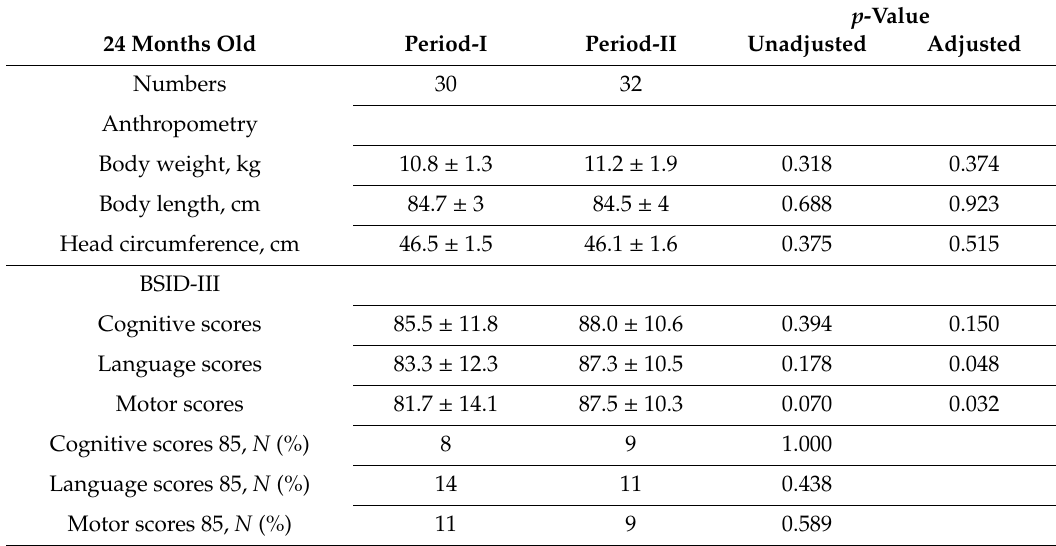
Table 5. Anthropometry and neurodevelopment outcomes at the corrected age of 24 months.